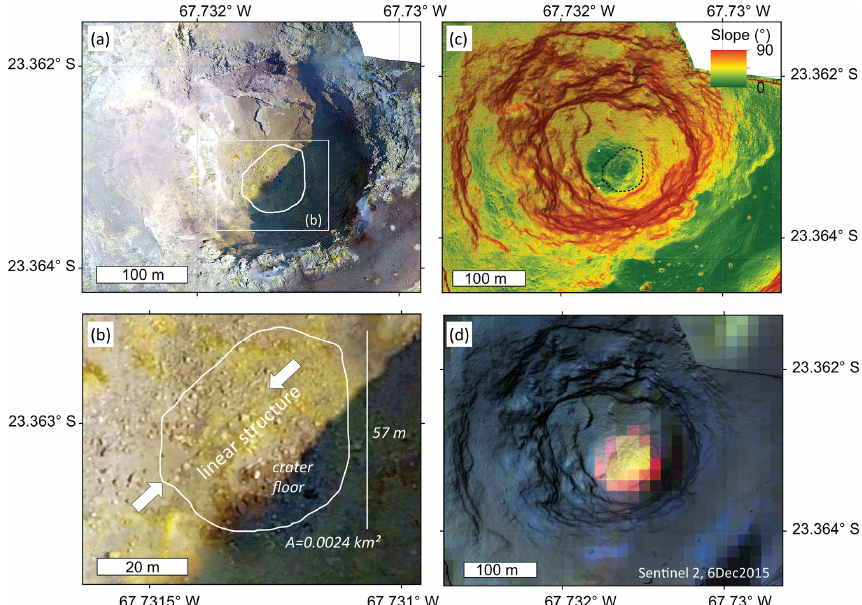
Figure 7. Drone overflight results. (a) Photomosaic of the crater region showing the 2017 central elevation of the crater floor with a diameter of 57m. The white line is the approximate perimeter of the thermal anomaly. (b) Close-up of photomosaic (as indicated in a ) showing the blocky central elevation of the crater floor which corresponds to the dimensions of the thermal anomaly. Note the NE–SW-striking linear feature transecting the central elevation. (c) Digital elevation shaded relief model overlaid by a slope map whose values represent the slope in degrees; the central elevation is delineated in the center of the crater. (d) Sentinel-2 thermal anomaly pixels acquired 37d after the eruption overlain on a shaded relief map to illustrate the location of the central elevation of the deep Lascar crater. Data provided by the European Space Agency